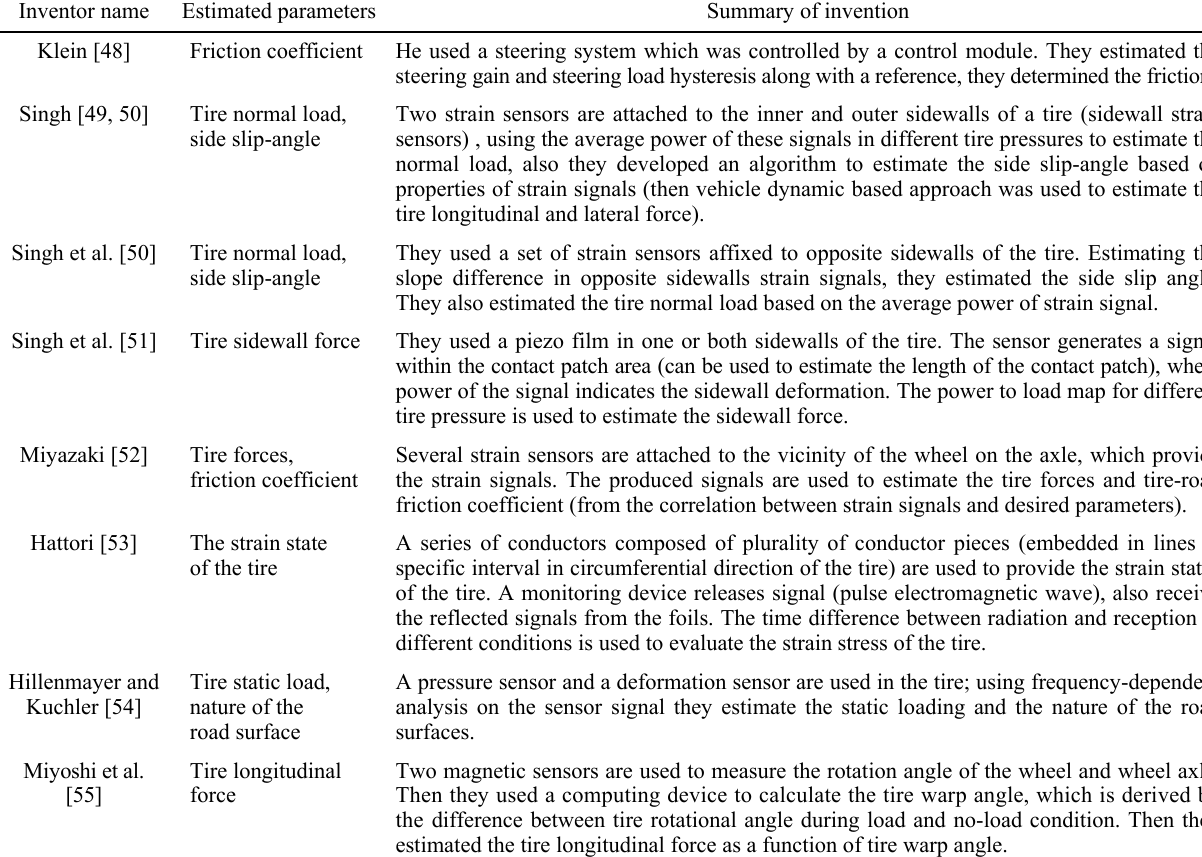
Table 1 Summary of the patents which have used experiment based